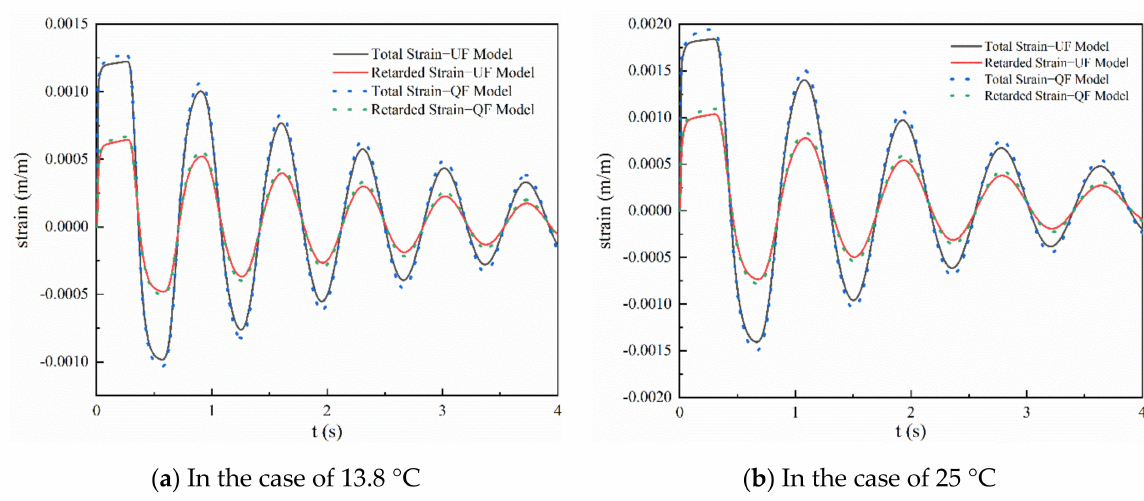
Figure 5. Comparison of total and retarded strains at different water temperatures: ( a ) 13.8 ◦ C; ( b ) 25 ◦